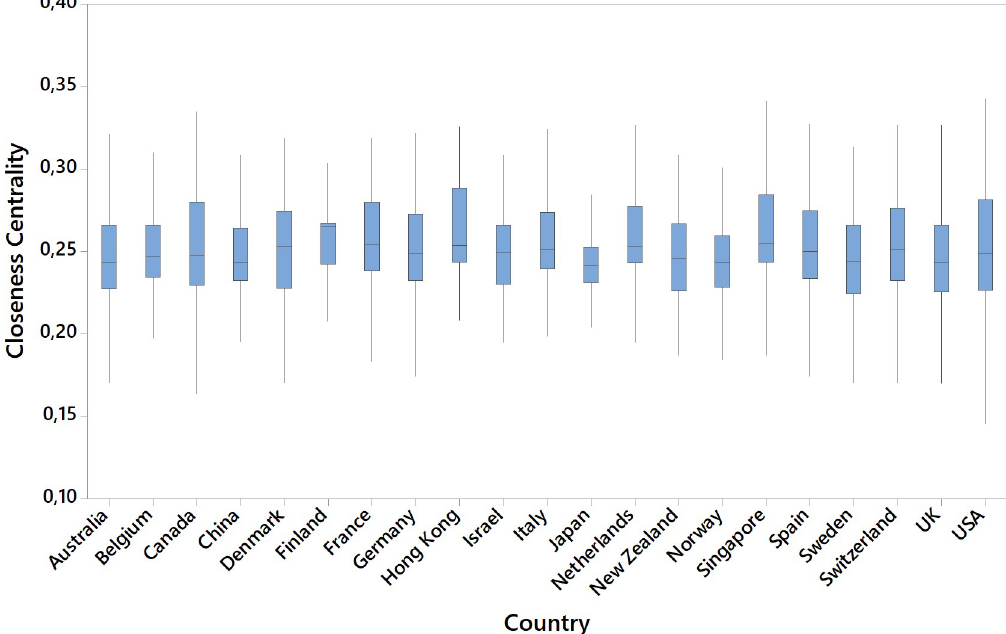
Fig 5. Boxplot of closeness centrality for countries with 100 or more EB members in the